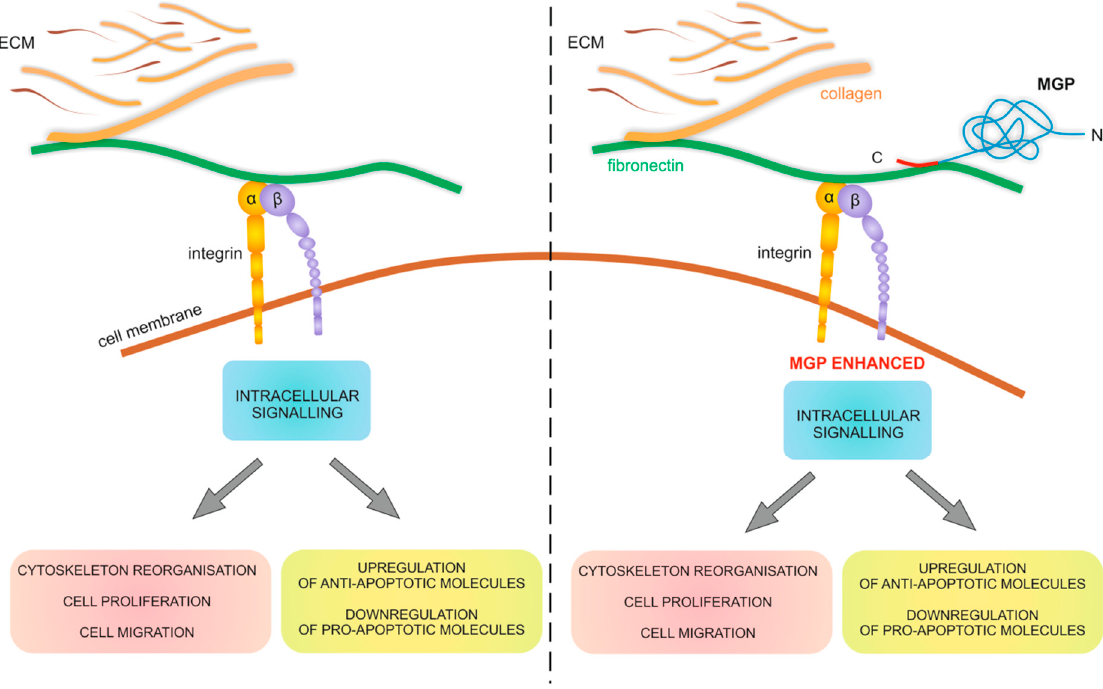
Figure 7. Schematic drawing of interaction between cell and ECM mediated by fibronectin and MGP. MGP augmented binding of integrins to ECM compounds activates intracellular signaling that results in: (1) cytoskeleton reorganization leading to increased cell proliferation and migration; and (2) upregulation of anti-apoptotic molecules and downregulation of pro-apoptotic molecules that inhibits drug-induced apoptosis.